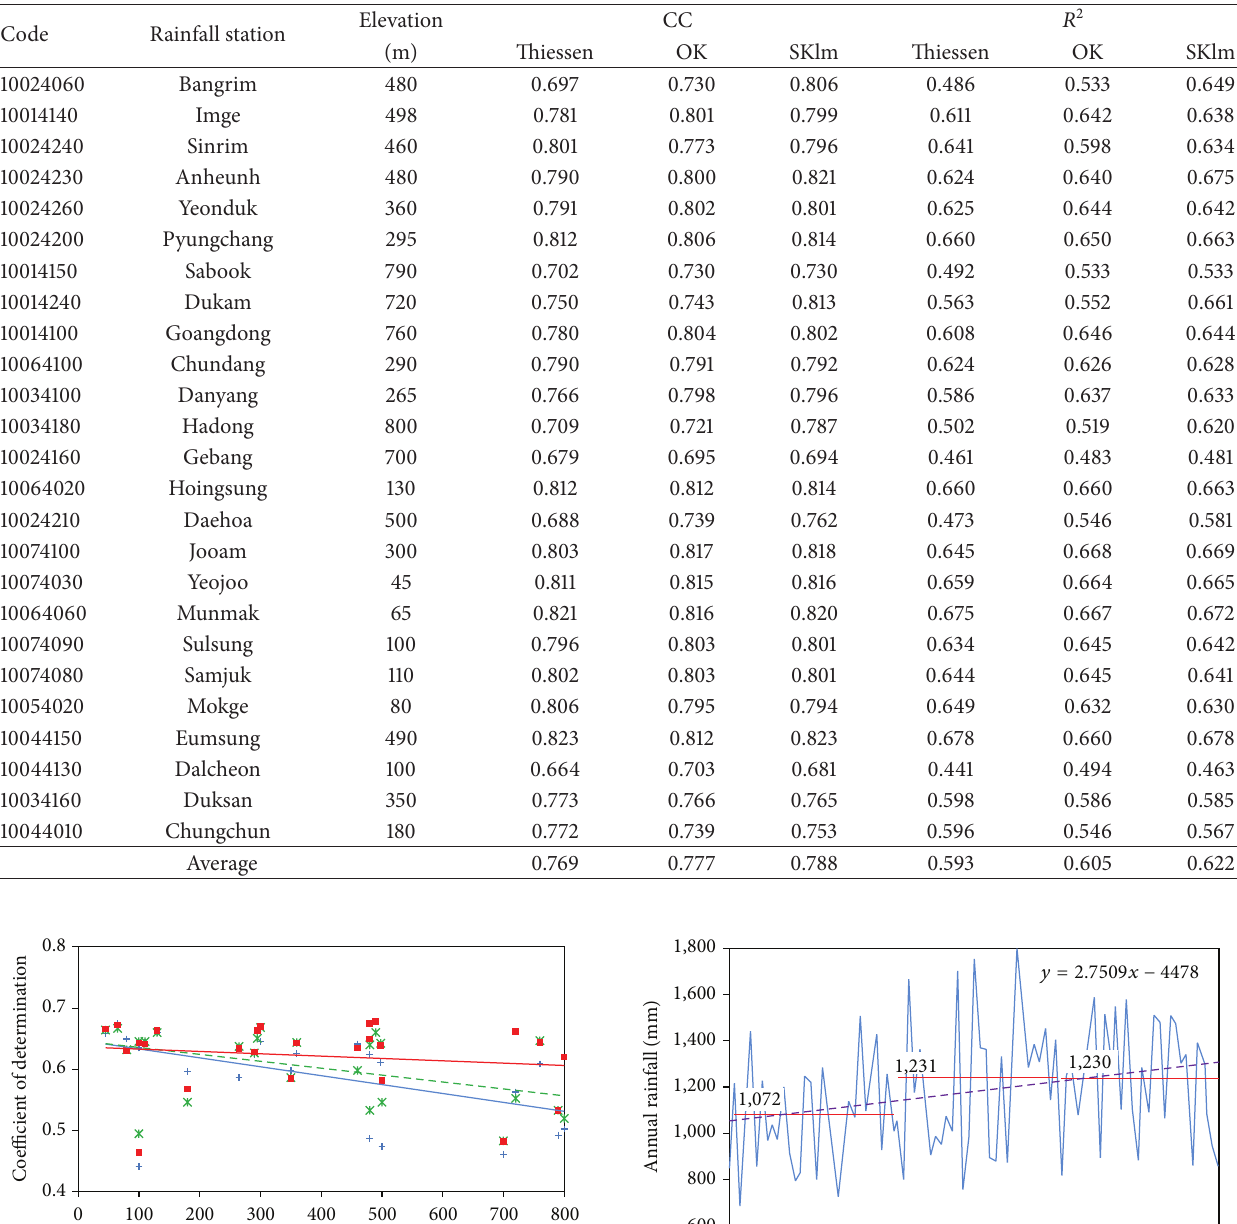
Table 3: Comparison of spatial interpolation techniques.